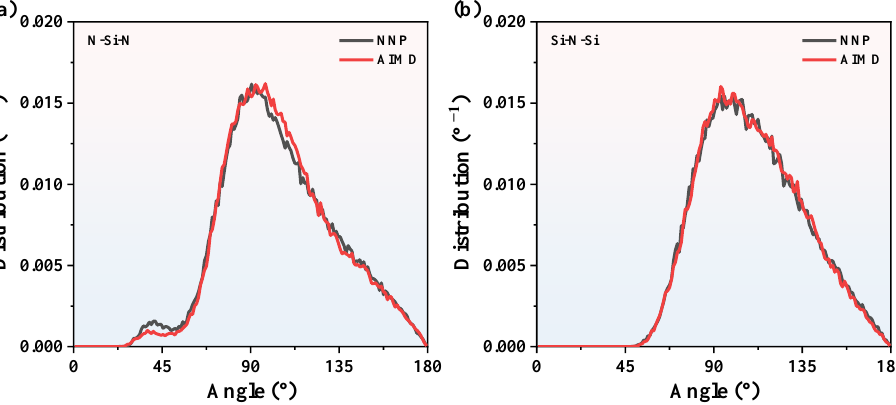
Figure 6. The BADs comparison of Si 3 N 4 between NNP + MD and AIMD at 3000 K. ( a ) the N-Si-N BADs, ( b ) the Si-N-Si BADs.